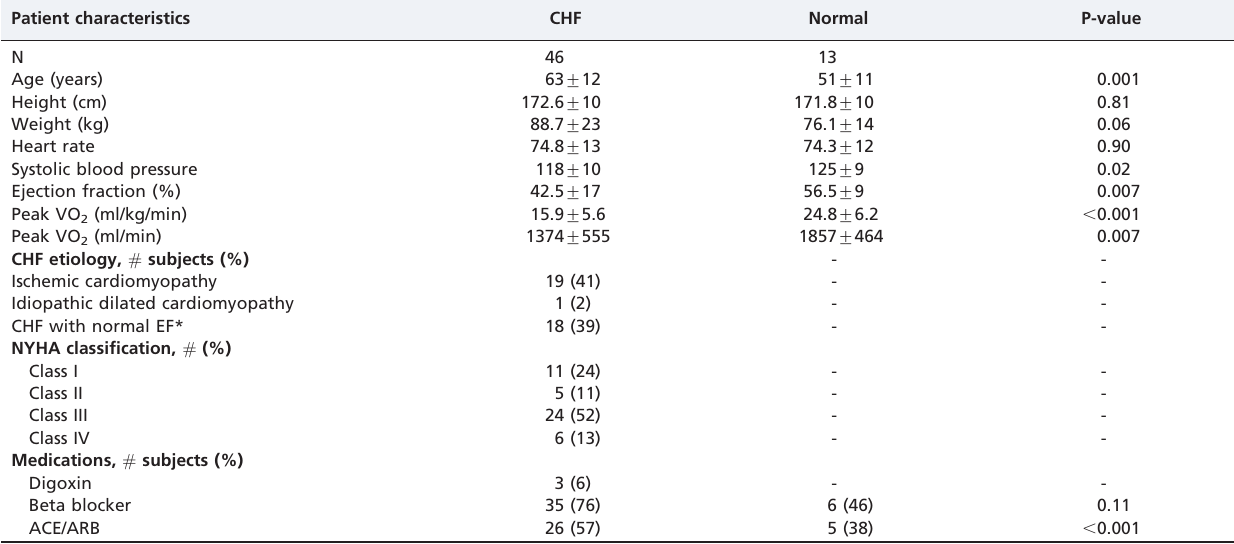
Table 1 - Demographic and Clinical